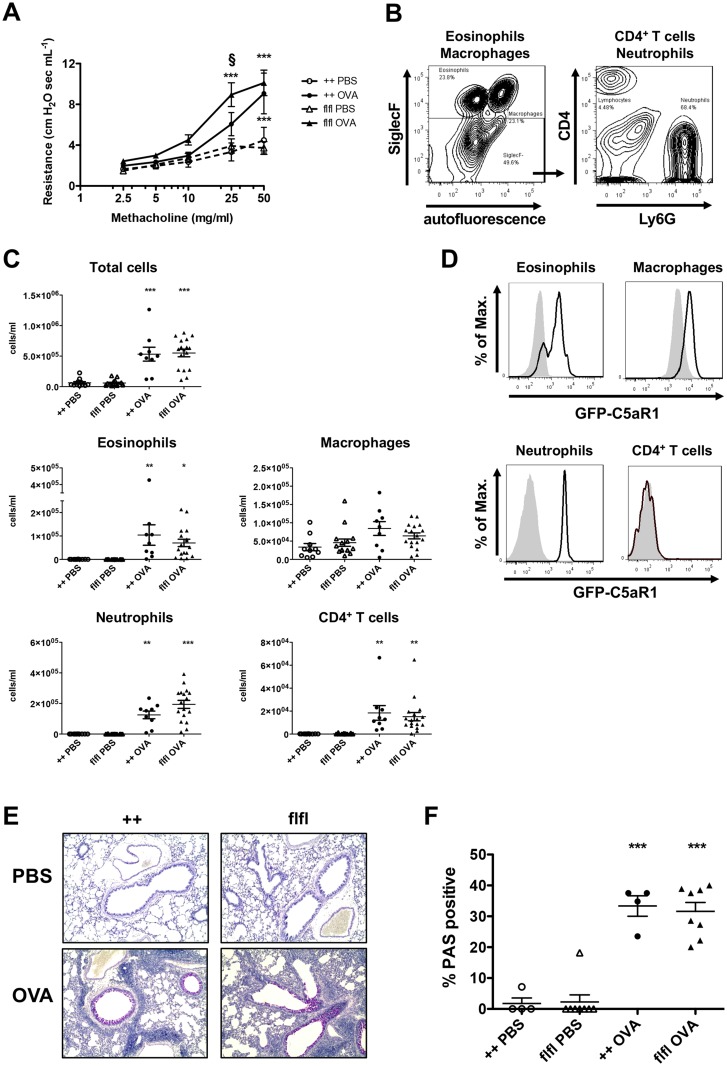
WT and GFP-C5aR1flox/flox mice develop a similar allergic asthma phenotype.(A) AHR in response to i.t. administration of methacholine measured as airway resistance. Shown are dose response curves in PBS-treated controls or OVA-immunized mice from WT (++) or GFP-C5aR1flox/flox (flfl) strains. Values shown are the mean ± SEM; n = 9–16 per group. (B) Gating strategy for the BAL fluid cell analysis. Cells were identified by flow cytometry using different markers to identify macrophages (SiglecF+autofluorescence+), eosinophils (SiglecF+autofluorescence-) neutrophils (SiglecF-Ly6G+CD4-), and T cells (SiglecF-Ly6G-CD4+). (C) Total and differential cell counts in BAL fluid of PBS-treated or OVA-immunized WT or GFP-C5aR1flox/flox animals. Values shown are the mean ± SEM; n = 9–17 per group. (D) GFP/C5aR1 expression in eosinophils, macrophages, neutrophils and CD4+ T cells from BAL fluid of GFP-C5aR1 reporter mice in response to OVA; grey histogram: WT controls. (E) Histological examination of mucus production in the airways of PBS-treated or OVA-immunized WT or GFP-C5aR1flox/flox animals. Sections were stained with PAS for mucus production (original magnification x 200). (F) Frequency of PAS-positive bronchi in PBS-treated or OVA-immunized WT or GFP-C5aR1flox/flox animals. Mucus producing airways are plotted relative to all analysed airways. Values shown are the mean ± SEM; n = 4–8 per group. * indicates significant differences between the PBS and OVA treatment groups; § indicates significant differences between OVA-treated WT and GFP-C5aR1flox/flox mice. * or § p < 0.05, ** p < 0.01, *** p <0.001.